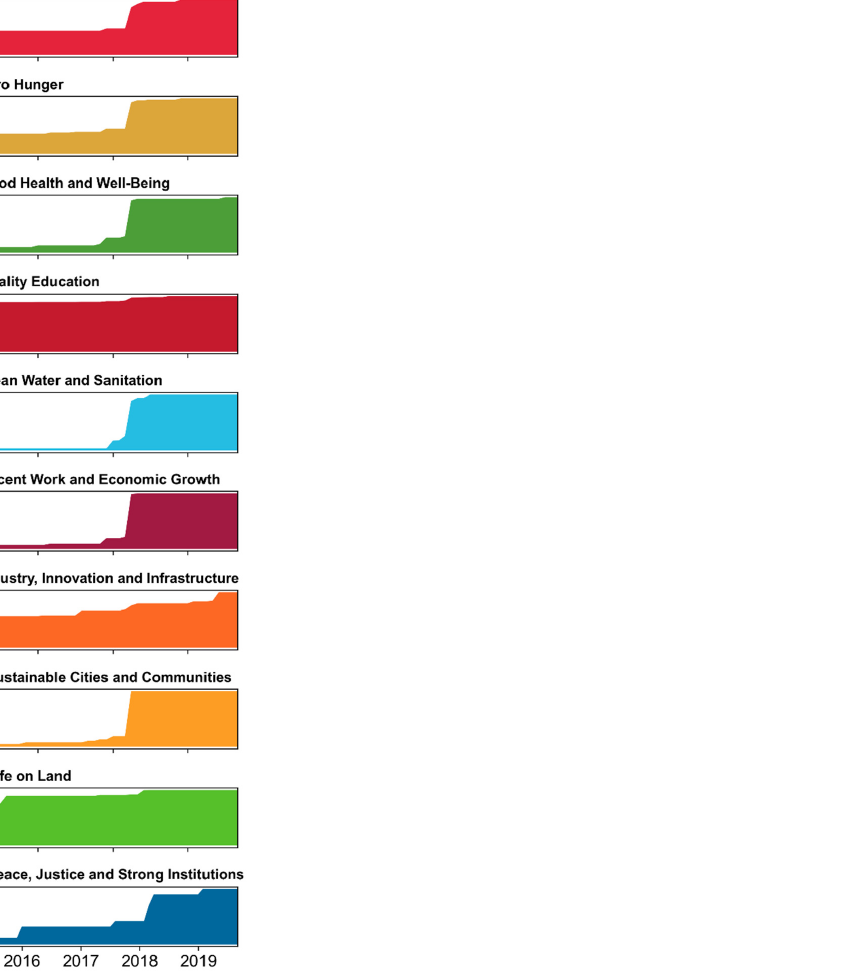
Figure 15. Cumulative timelines of V1 data creation dates across all 1919 SDG-relevant OSM features in non-refugee settlements.